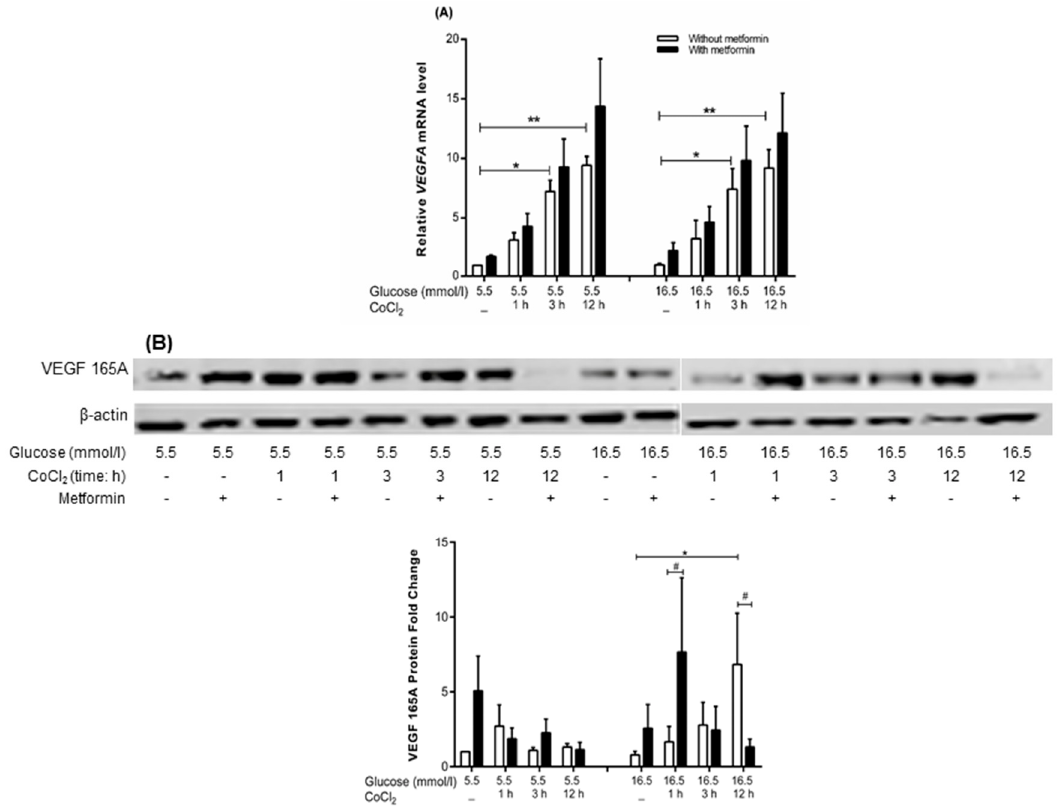
Figure 4. Effect of metformin on VEGFA mRNA and VEGF 165A protein under euglycemia-CoCl 2 , hyperglycemia and hyperglycemia-CoCl 2 . HUVEC were treated with hyperglycemic or euglycemic glucose concentrations as a control. After 24 h, metformin was added to euglycemic and hyperglycemic cultures, then CoCl 2 was added for either 1, 3 or 12 h. ( A ) The variation in mRNA expression levels of VEGFA was assessed by qRT-PCR on three independent biological replicates and ( B ) the variation in protein levels of VEGF 165A was assessed by western blot on three independent biological replicates. Results are presented as mean ± SEM and were analyzed using one-way ANOVA followed by LSD, * p < 0.05, ** p < 0.01 compared to the control. # p < 0.05 compared pairwise, i.e.; metformin-treated condition versus untreated condition.